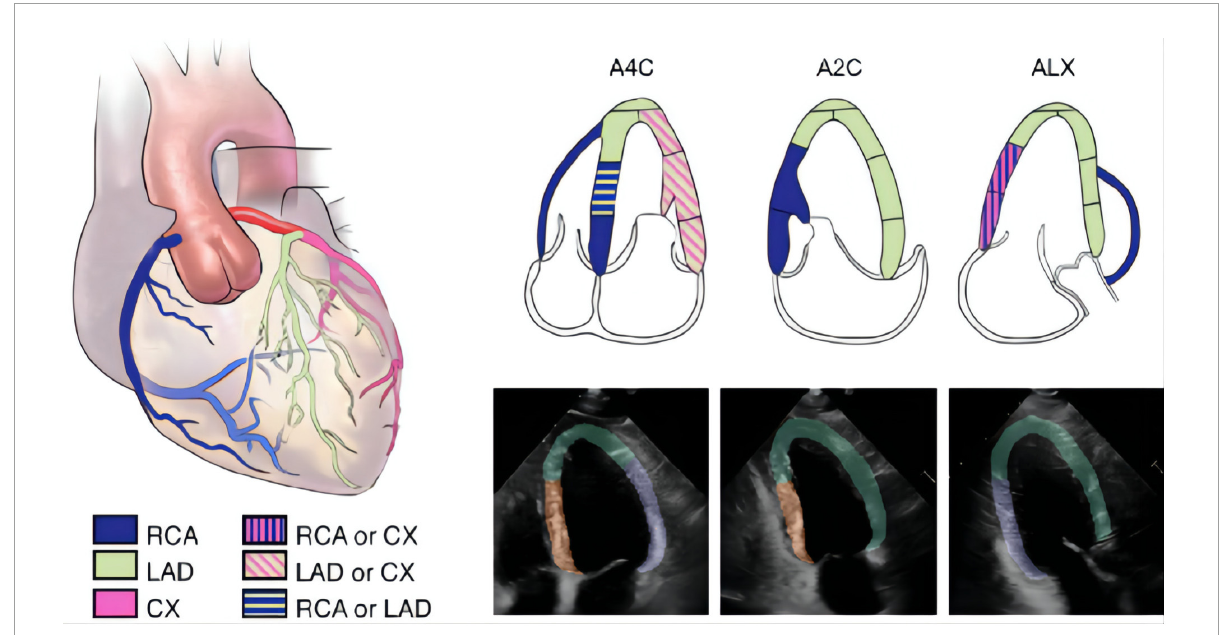
FIGURE2 The segmentation of different wall regions. The 2015 ASE guideline recommend typical distributions of the coronary artery in apical four-chamber (A4C), apical two-chamber (A2C), and apical long-axis (ALX) views. In the echocardiographic images, we labeled A for apical, anterior and anteroseptal walls (green area), F for inferior and inferoseptal walls (orange area), and L for anterolateral and inferolateral walls (purple